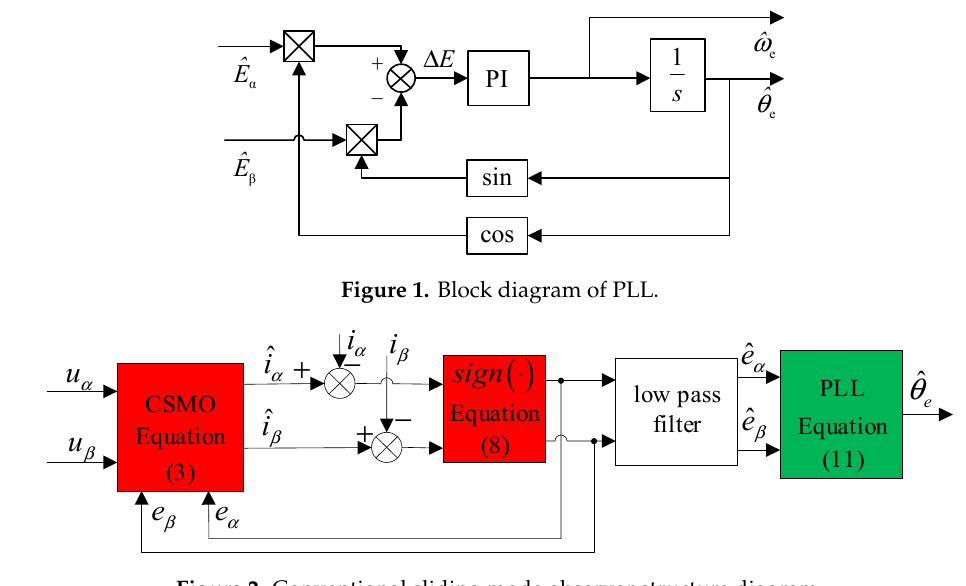
Figure 2. Conventional sliding mode observer structure diagram.